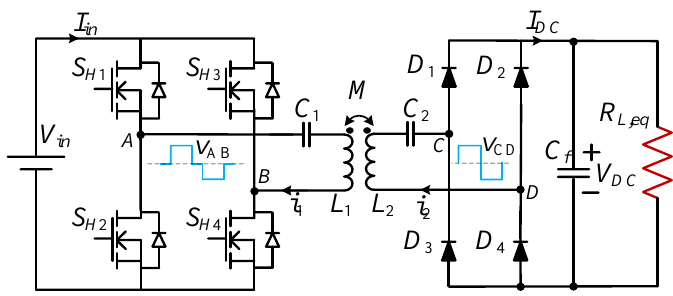
Figure 4. WPTS with the equivalent load.